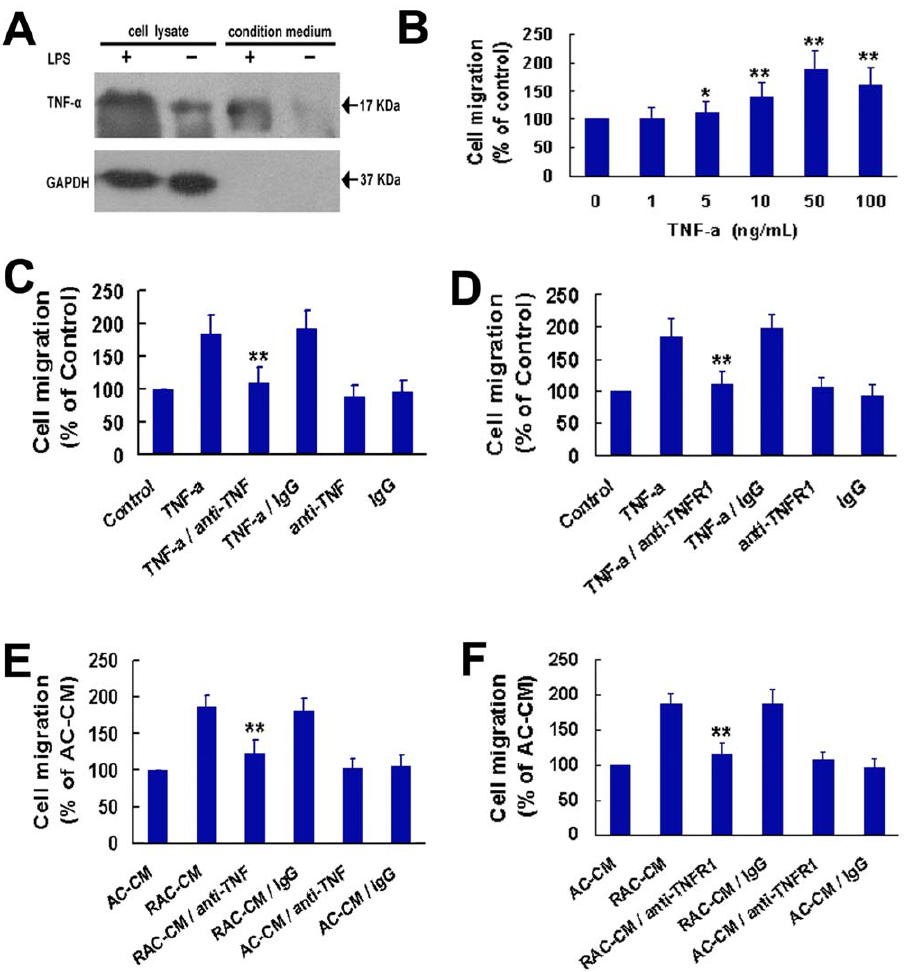
Figure 4. Reactive astrocytes secrete TNF- a to promote OECs migration by interacting with TNFR1. (A) Reactive astrocytes produce TNF- a . The cell lysate and condition medium of OECs treated ( + ) or untreated ( 2 ) with LPS (10 m g/mL) at 37 u C for 24 hr were subjected to immunoblotting with antibody against TNF- a (upper panel) and anti-GAPDH (lower panel). (B) Dose dependency of TNF- a effect on OECs migration. * P , 0.05 versus control, ** P , 0.01 versus control. (C, D) The effect of TNF- a on the migration of OECs is mediated by TNFR1. Medium or OECs were pretreated with TNF- a antibody (5 m g/mL), TNFR1 antibody (2 m g/mL) or goat IgG for 2 hr and applied to Boyden chamber migration assays, stimulated with TNF- a (50 ng/mL). Cells without pretreatment but with TNF- a stimulation were defined as TNF- a group. Cells with neither pretreatment nor TNF- a stimulation were defined as control. ** P , 0.01 versus TNF- a group. (E, F) TNF- a in RAC-CM is involved in mediating the migration-promoting activity of OECs. RAC-CM or OECs were pretreated with TNF- a antibody (5 m g/mL), TNFR1 antibody (2 m g/mL) or goat IgG for 2 hr, then stimulated with RAC-CM. Cells without pretreatment but with RAC-CM stimulation were defined as RAC-CM group. Cells without pretreatment but with AC-CM stimulation were defined as AC-CM group. ** P , 0.01 versus RAC-CM